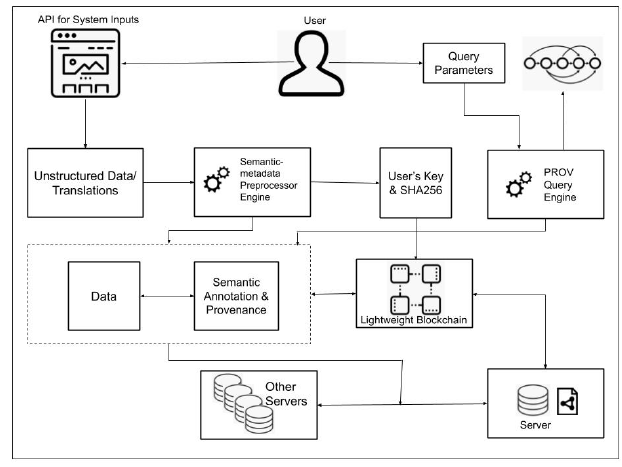
Figure 1. MultiVerse ’s Architecture